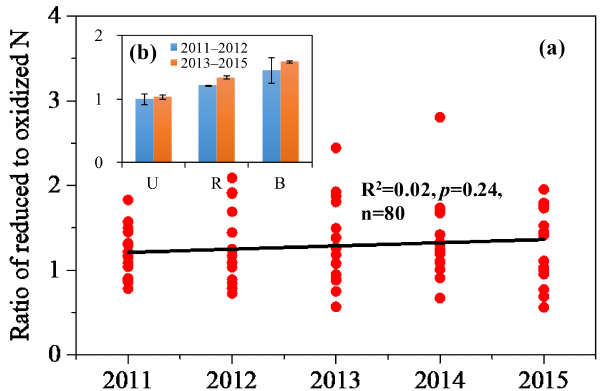
Figure 8. Annual trend of the ratio of NH x (wet/bulk NH + position plus dry deposition of NH 3 and particulate NH + (wet/bulk NO − -N deposition plus dry deposition of NO 2 , HNO 3 3 and particulate NO − ) across 16 selected sites (a) , with a compar- 3 ison between the 2011–2012 period and the 2013–2015 period for different land use types in eastern China (b) . U, R, and B denote urban, rural, and background sites respectively. The number of sites with the same land use type can be found in Fig. S6 in the Supple-